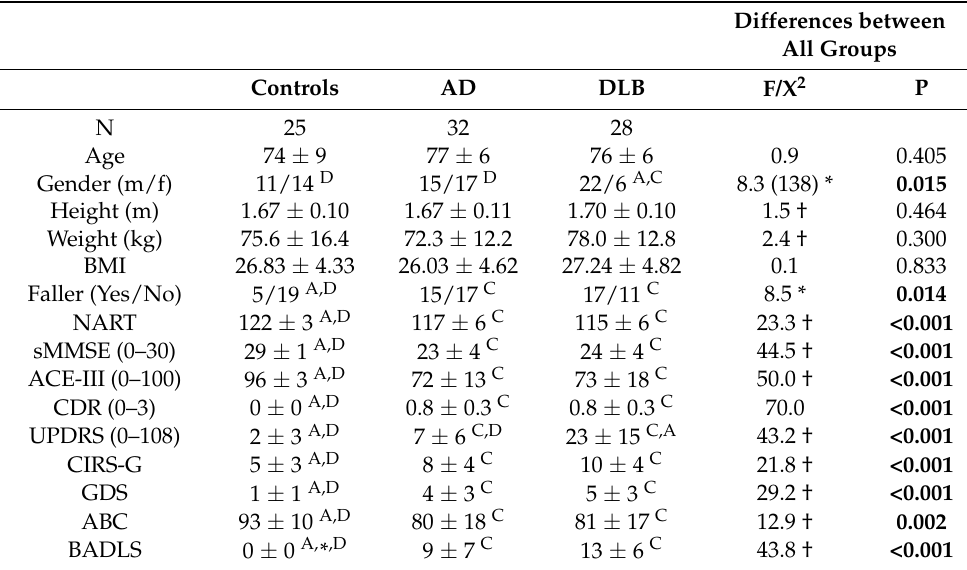
Table 1. Demographic, clinical and cognitive information for all groups.